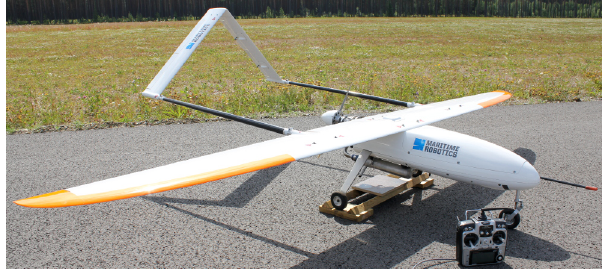
Figure 7: Maritime Robotics’ Penguin B from UAV Factory that was used during